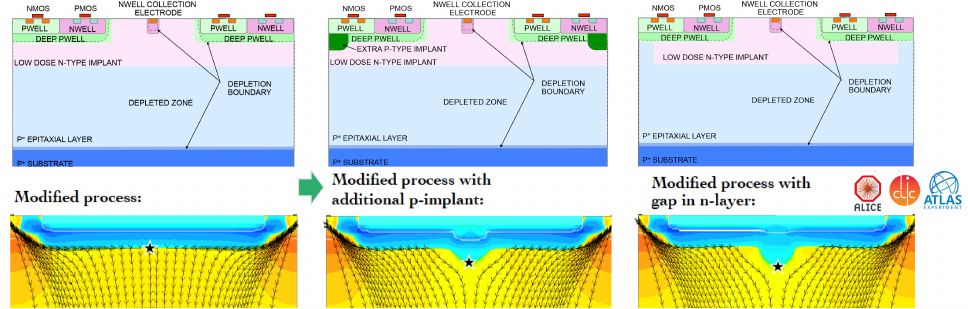
Figure 1. Cross-sections of MAPS structures and electric field lines in the improved process. At CERN, the ALICE ITS3 upgrade based on MAPS is driving the CERN WP1.2 collaboration investigating wafer-scale MAPS devices on the TowerSemi 65 nm